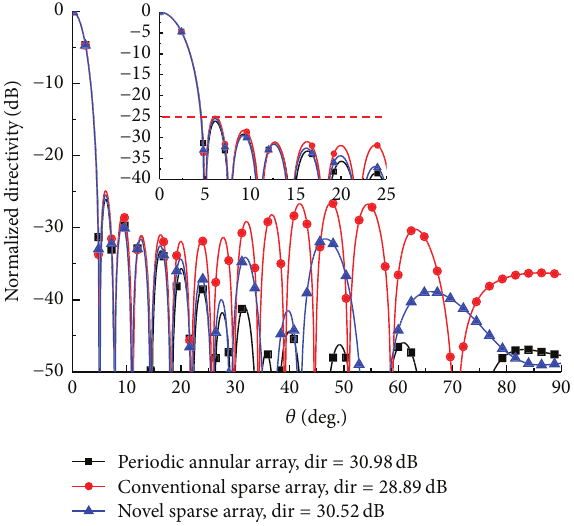
Figure 3: Pattern synthesis results of − 25dB SLL pattern.